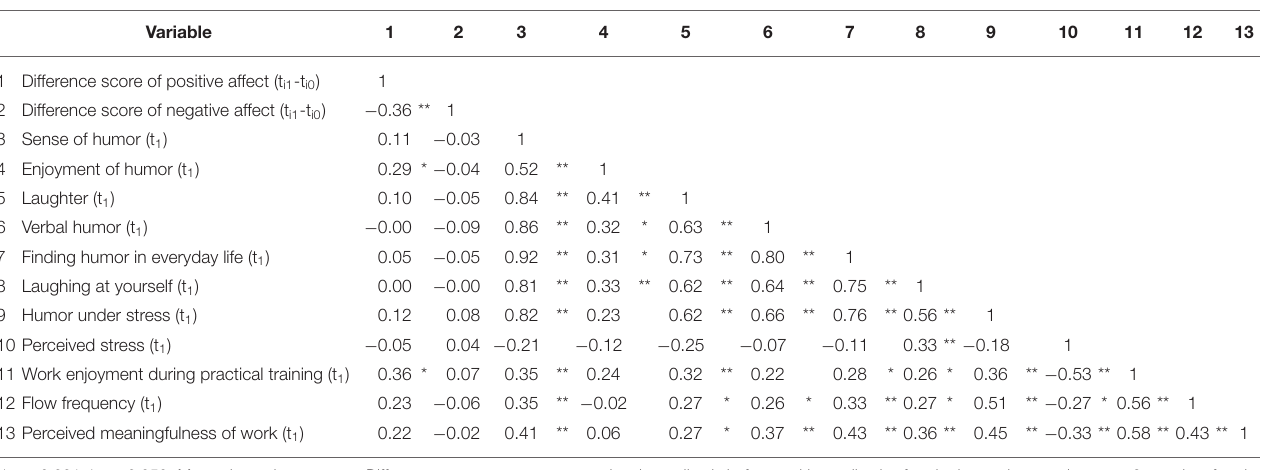
The sense of humor thus transmits a positive effect of the humor intervention on flow frequency. For an overview, see Figure 6 . Testing Hypothesis 5: Sense of humor mediates the effect of the humor intervention on the perceived meaningfulness of work. The mediation model involved sense of humor (t 1 ) as mediator and the perceived meaningfulness of work (t 1 )